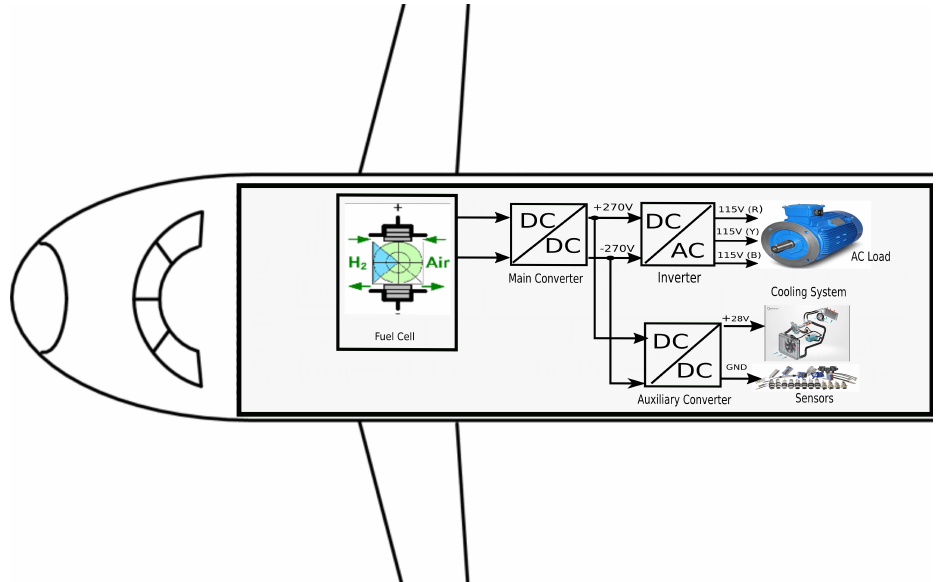
Figure 1. MEA architecture demonstrating voltage